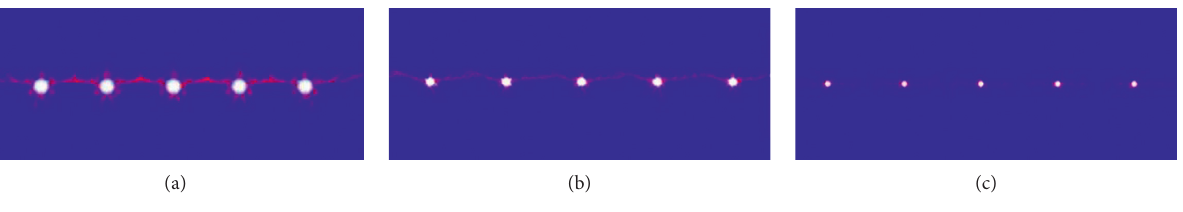
Figure 5: Blasting effect of different blast hole spacing. (a) Blasting spacing 400mm. (b) Blasting spacing 500mm. (c) Blasting spacing